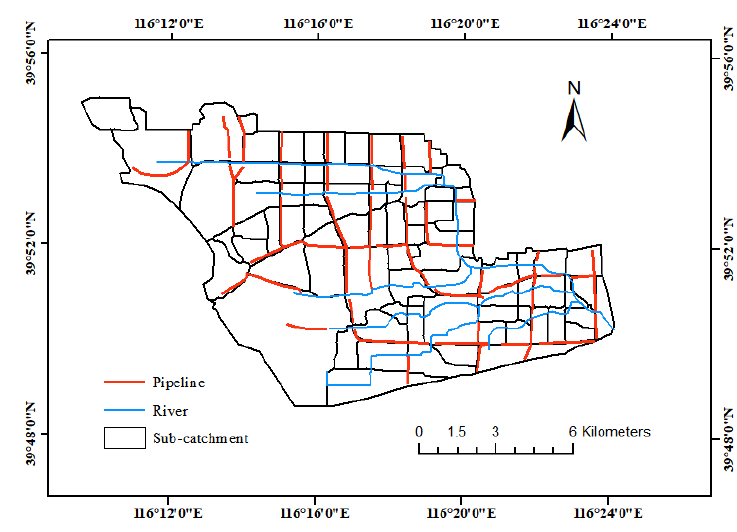
Figure 2. Structure of Storm Water Management Model (SWMM) model in Dahongmen catchment.